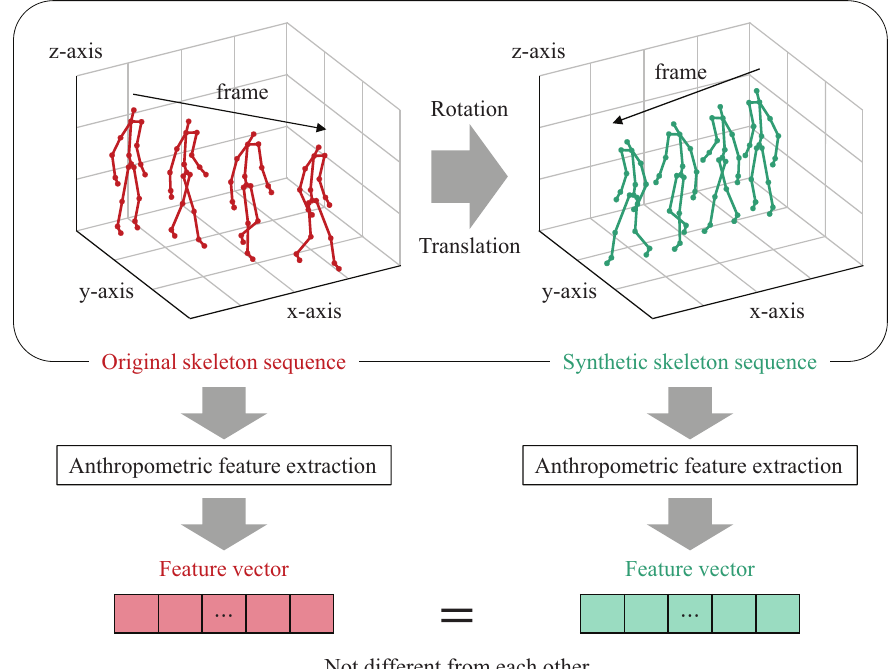
Figure 2. Feature vector extracted from original skeleton sequence is not different to that from synthetic skeleton sequence.